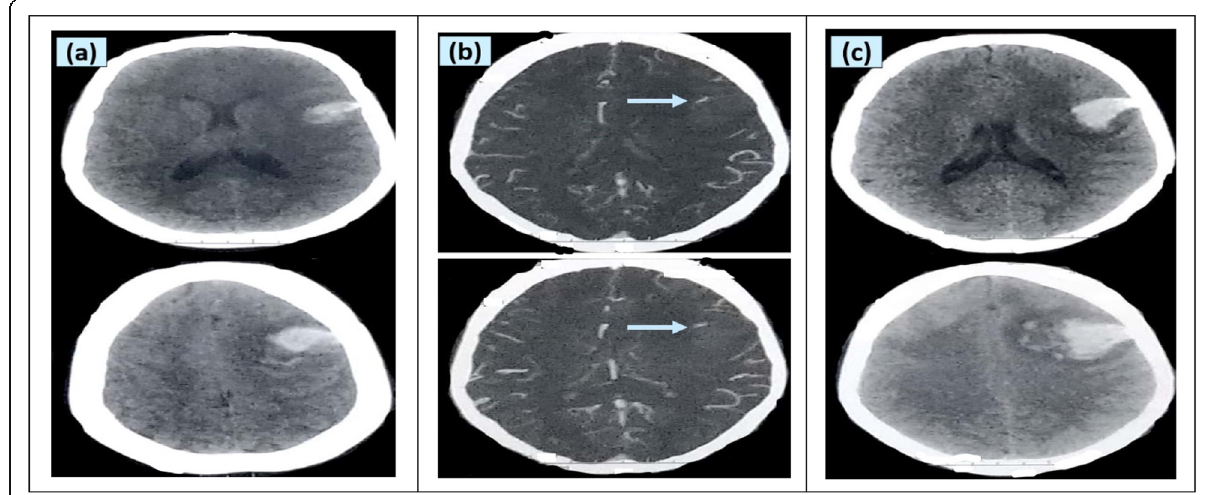
Fig. 2 An included patient with sudden onset of right side hemiparesis and dysphasia ( a ) baseline non contrast CT shows left tempro-parietal lobar hematoma, ( b ) early CT angiography done 4 hours after admission shows positive spot sign, ( c ) 48-hours follow-up non-contrast CT shows hematoma